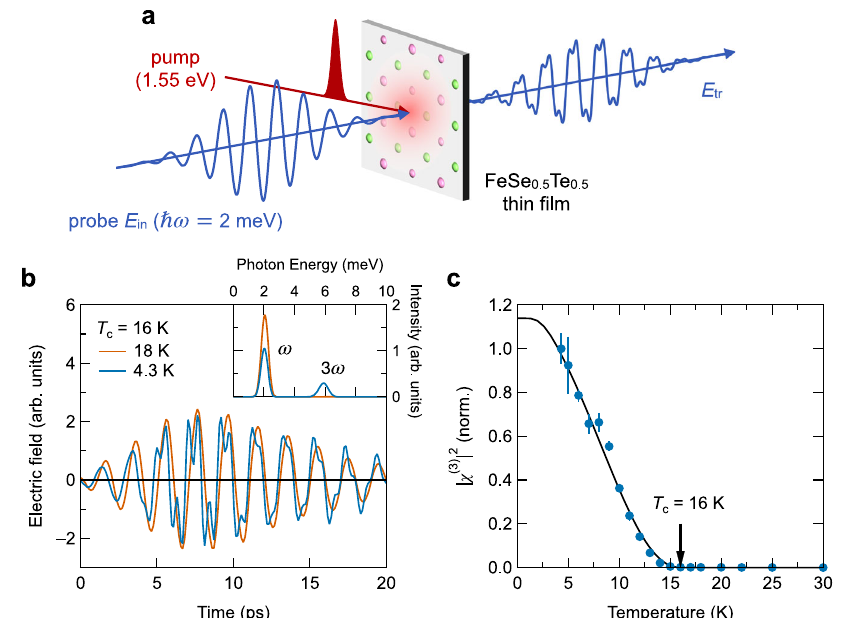
Fig. 3 THz-THG signal from FeSe 0.5 Te 0.5 in equilibrium. a Schematic illustration of the terahertz third-harmonic generation (THz-THG) measurement. Narrowband THz probe pulse with the center photon energy of _ ω = 2 meV (0.5 THz in frequency) is used. A near-infrared pump pulse, used for the photoexcitation, is also shown by red. The results shown in b , c are obtained without the pump pulse. b Time-domain waveform of the transmitted THz pulses at 18 and 4.3 K (red and blue, respectively), along with the power spectra shown in the inset. 1.5 THz bandpass fi lters are inserted after the sample to reduce the transmitted fundamental component. c Temperature dependence of the squared magnitude of the THG susceptibility, χ 3 ð Þ intensities of the observed TH and fundamental signals, I TH and I F . Error bars represent the standard deviation. The fi t curve by assuming the Higgs mode response represented by Eq. (1) in the text is also shown by the solid